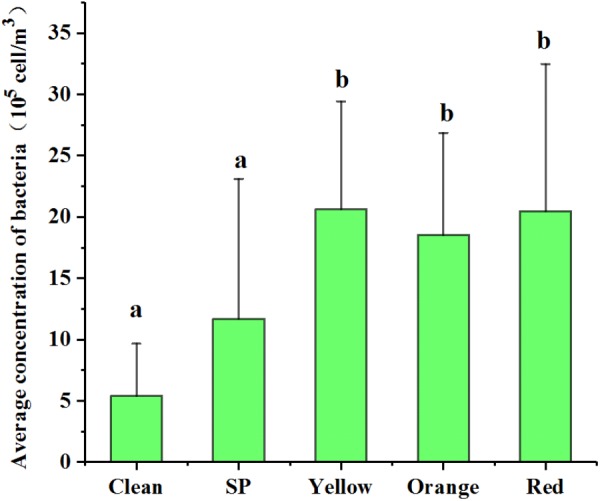
Variation of bacterial concentration during different haze pollution levels. Clean, SP (Slightly Polluted), yellow, orange, and red represent the haze pollution levels from non-haze to severe haze. Statistical significance is indicated by different letters (a, b) in columns as assessed by ANOVA (p < 0.05).